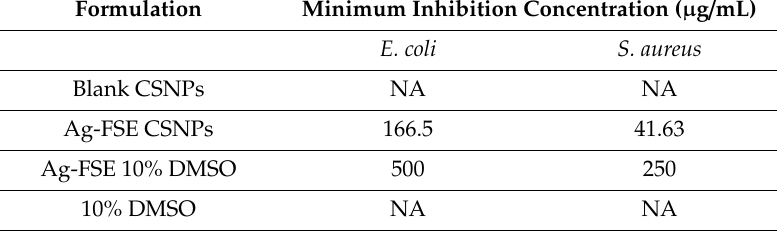
Table 4. Minimum inhibition concentrations for blank CSNP, Ag-FSE CSNP, Ag-FSE-10%, DMSOm and 10% DMSO against E. coli and S. aureus (n = 3).